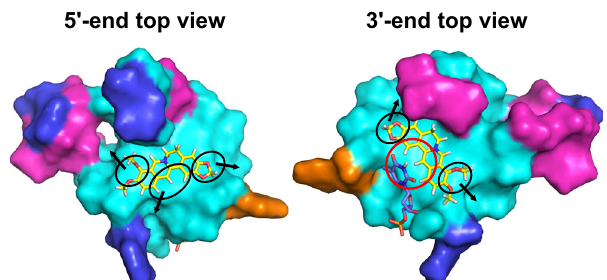
Fig. 8 | Suggested modi fi cations of berberine enabling additional interaction with the KRAS -G4. The black circles indicate the positions to be modi fi ed by introducingsidechainsforgrooveinteractions.Theblackarrowsshowthegrooves at 5 ′ - and 3 ′ -sites where the attached side chain will locate. The red circle suggests the positions to introduce hydrogen bonds between berberine and thymine T10. The KRAS -G4isshownincartoonrepresentation.Cyan,guanine;magenta,adenine; blue, thymine; orange, cytosine; yellow, berberine.